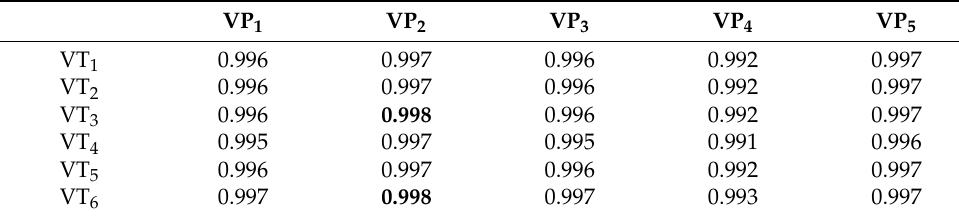
Table 11. Pearson’s correlation matrix for the year 2018.